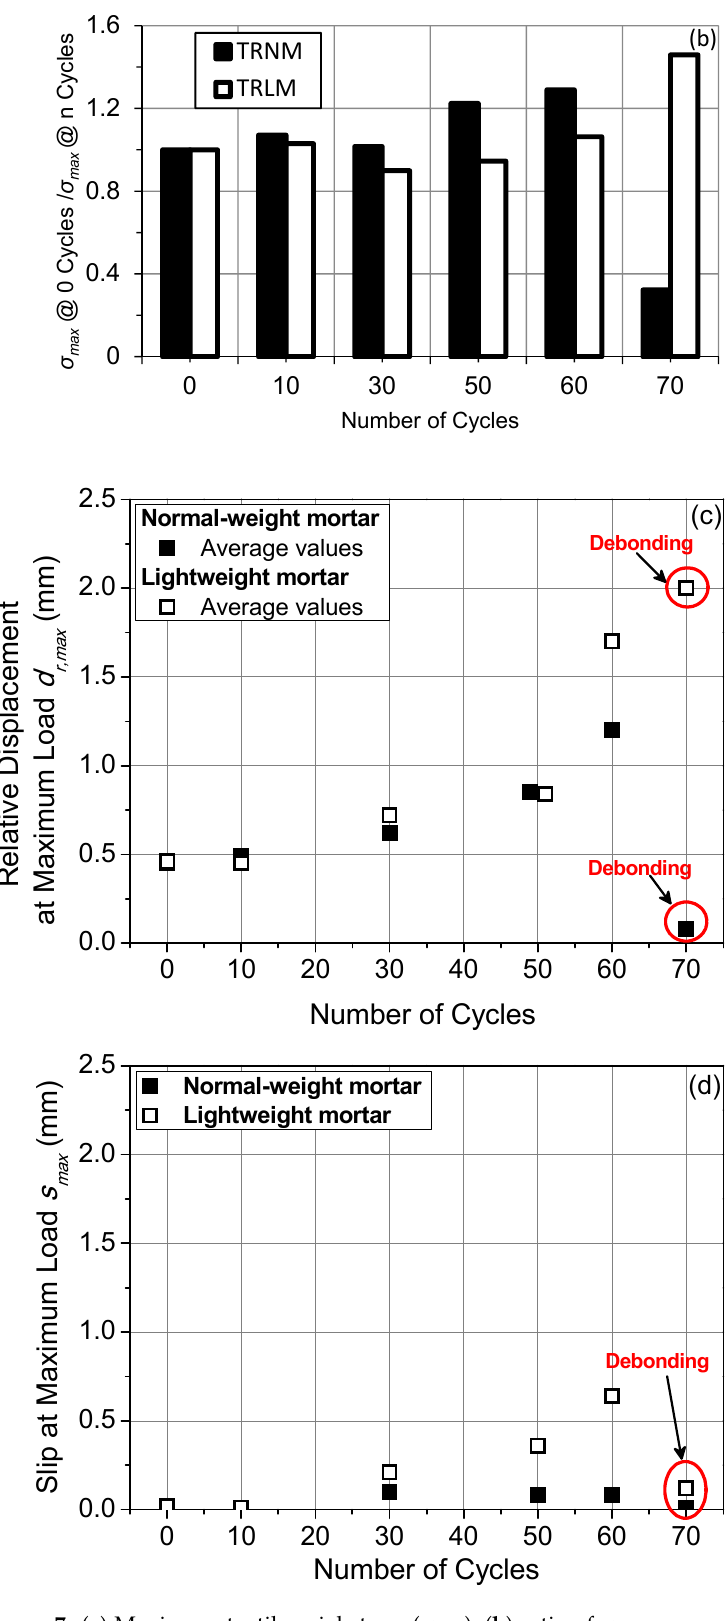
Figure 7. ( a ) Maximum textile axial stress ( σ max ), ( b ) ratio of σ max corresponding to the reference specimens to σ max of exposed specimens, ( c ) relative displacement ( d r,max ), and ( d ) slip ( s max ) corresponding to σ max versus number of freeze–thaw cycles.